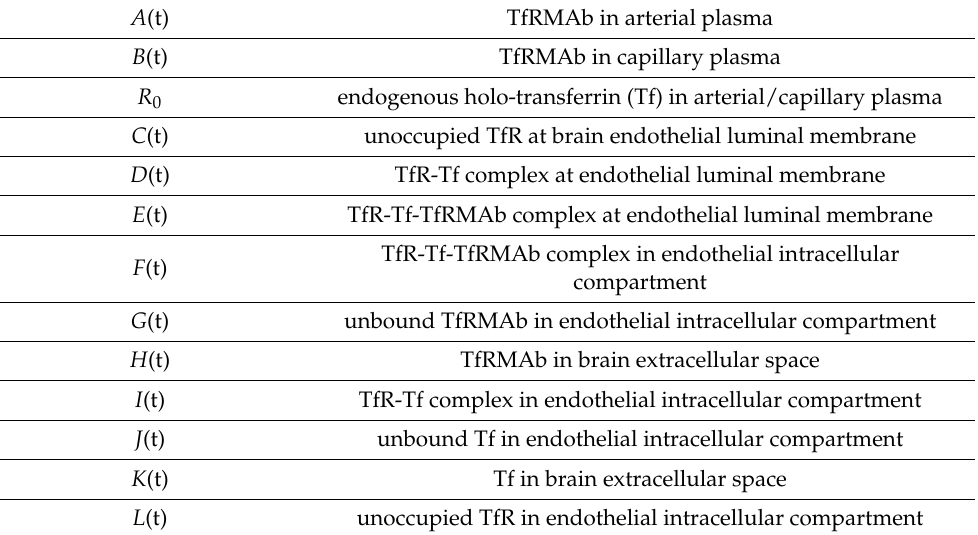
Table 1. Definitions of concentration variables for TfR model.